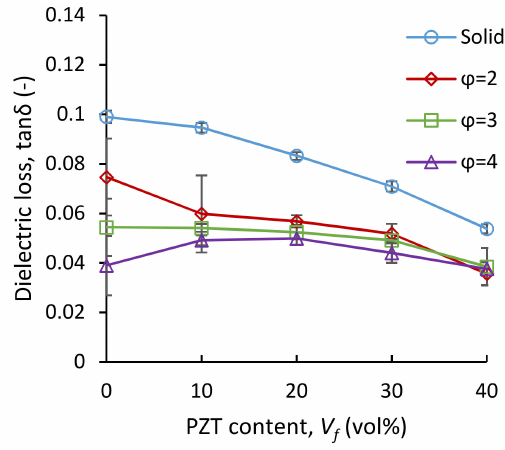
Figure 8. Dielectric loss of TPU/PZT composites as a function of PZT content at the expansion ratios of ϕ = 2 ( V f = 0.5), ϕ = 3 ( V f = 0.67), and ϕ = 4 ( V f =